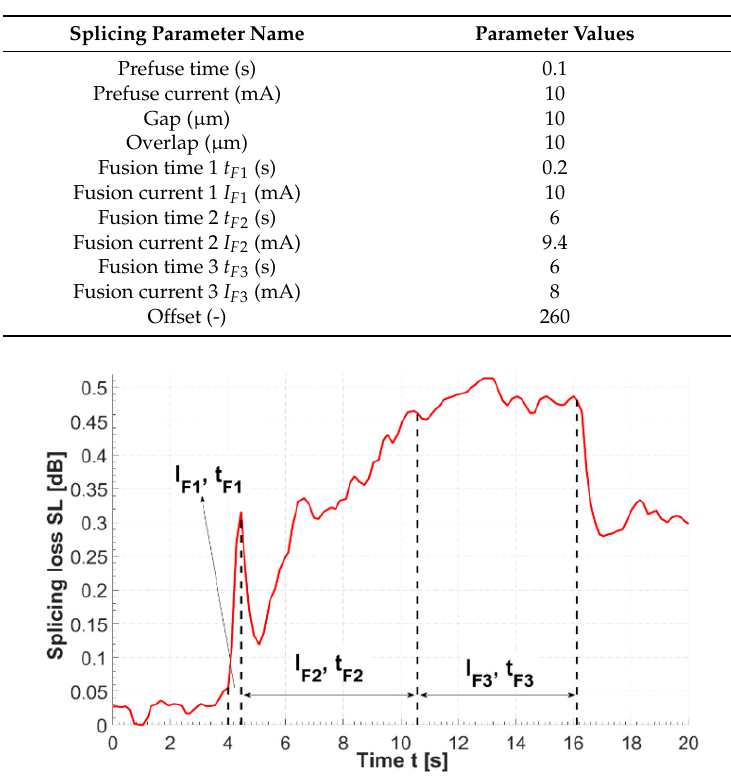
Table A1. Arc fusion splicer parameters adjusted for splicing hollow-core photonic crystal fiber lens curvature was small enough (about 150 µm), while large values of the arc currents made the